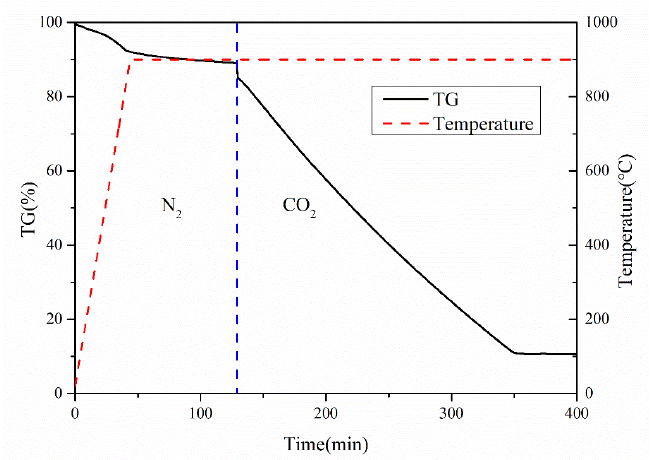
Figure 7. Schematic sketch of the reaction process.